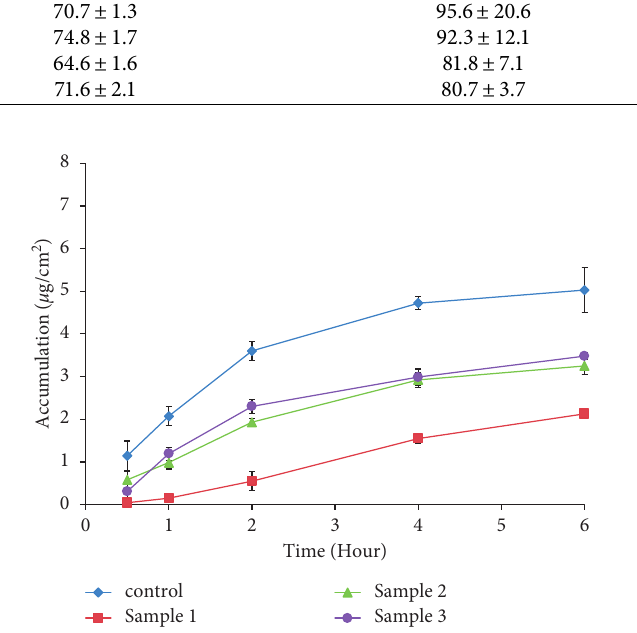
Figure 3: In vitro release profiles of octyl methoxycinnamate